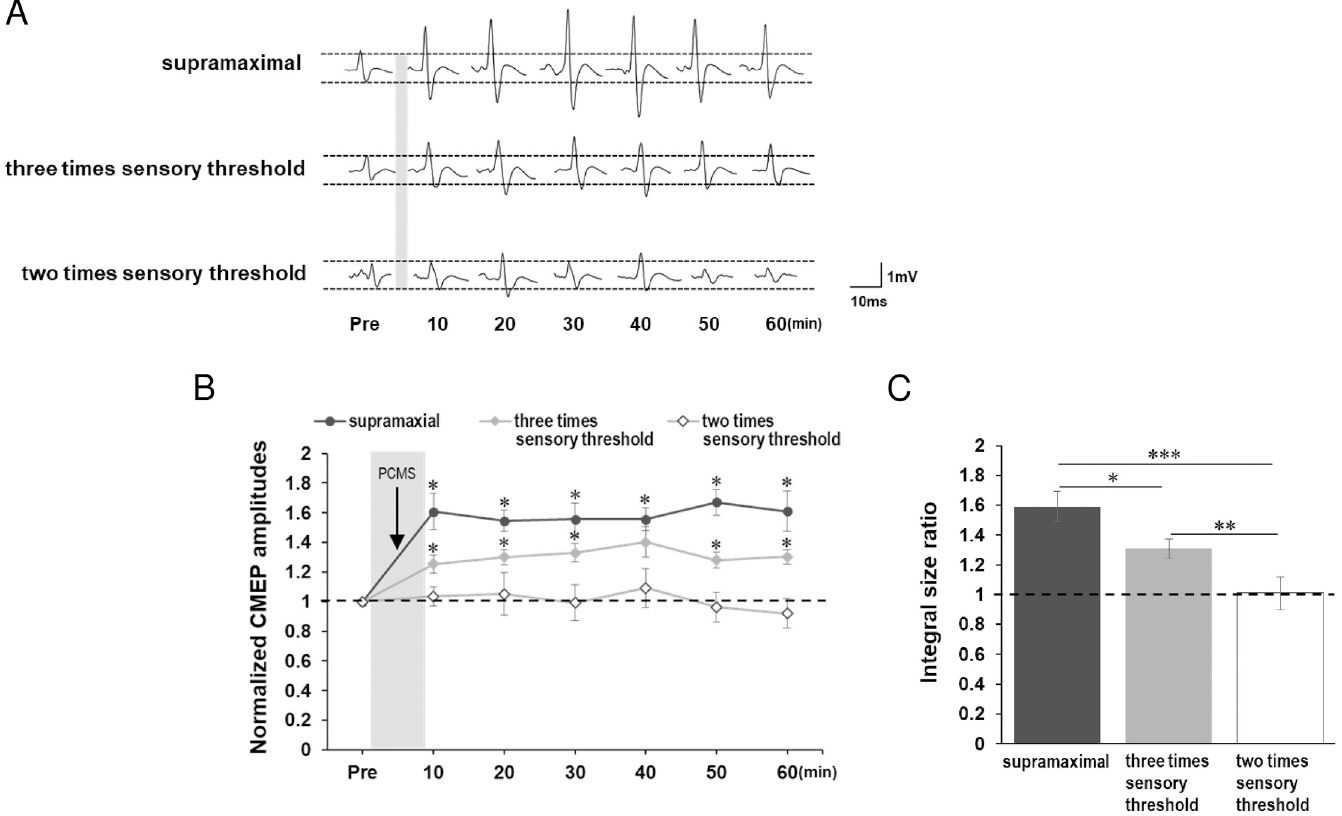
Fig 3. Normalized CMEP amplitudes after PCMS in Experiment 1 and influences of PNS intensity on PCMS effects in Experiment 2. (A) Representative CMEP waveforms before and after the intervention. (B) Time courses of the average CMEP size ratio from 10 to 60 min after PCMS at supramaximal PNS intensity, three times the sensory threshold, and two times the sensory threshold. CMEP increased after PCMS at supramaximal PNS intensity and at three times the sensory threshold, while PCMS at two times the sensory threshold showed no significant changes. (C) The ISR of PCMS. The ISR of PCMS at the supramaximal PNS was the greatest among the protocols. The ISR of PCMS at three times the sensory threshold was larger than that of PCMS at two times the sensory threshold. � P < 0.05, �� P < 0.01, ��� P < 0.001. All data are mean and standard-error values.